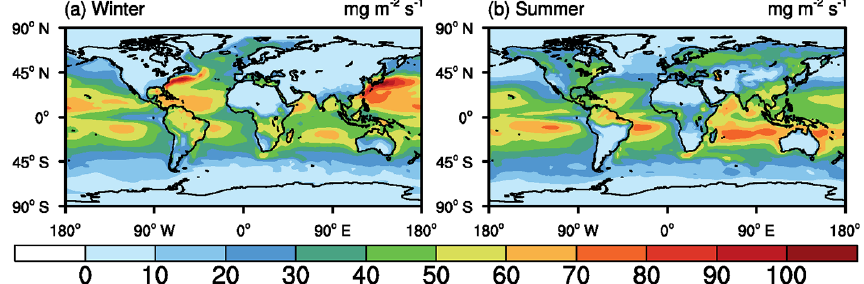
Figure 4. Distribution of CAM5.1’s 10-year-averaged surface evaporation flux (unit: mgm − 2 s − 1 ) in (a) winter and (b) summer between 1998 and